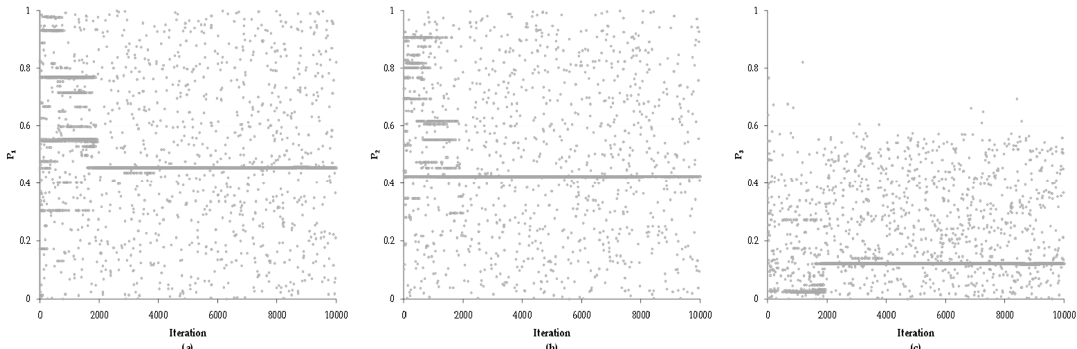
Figure 11. Behavior of the probability parameter for the EV1-3P with respect to the iterations of ( a ) P 1 ;